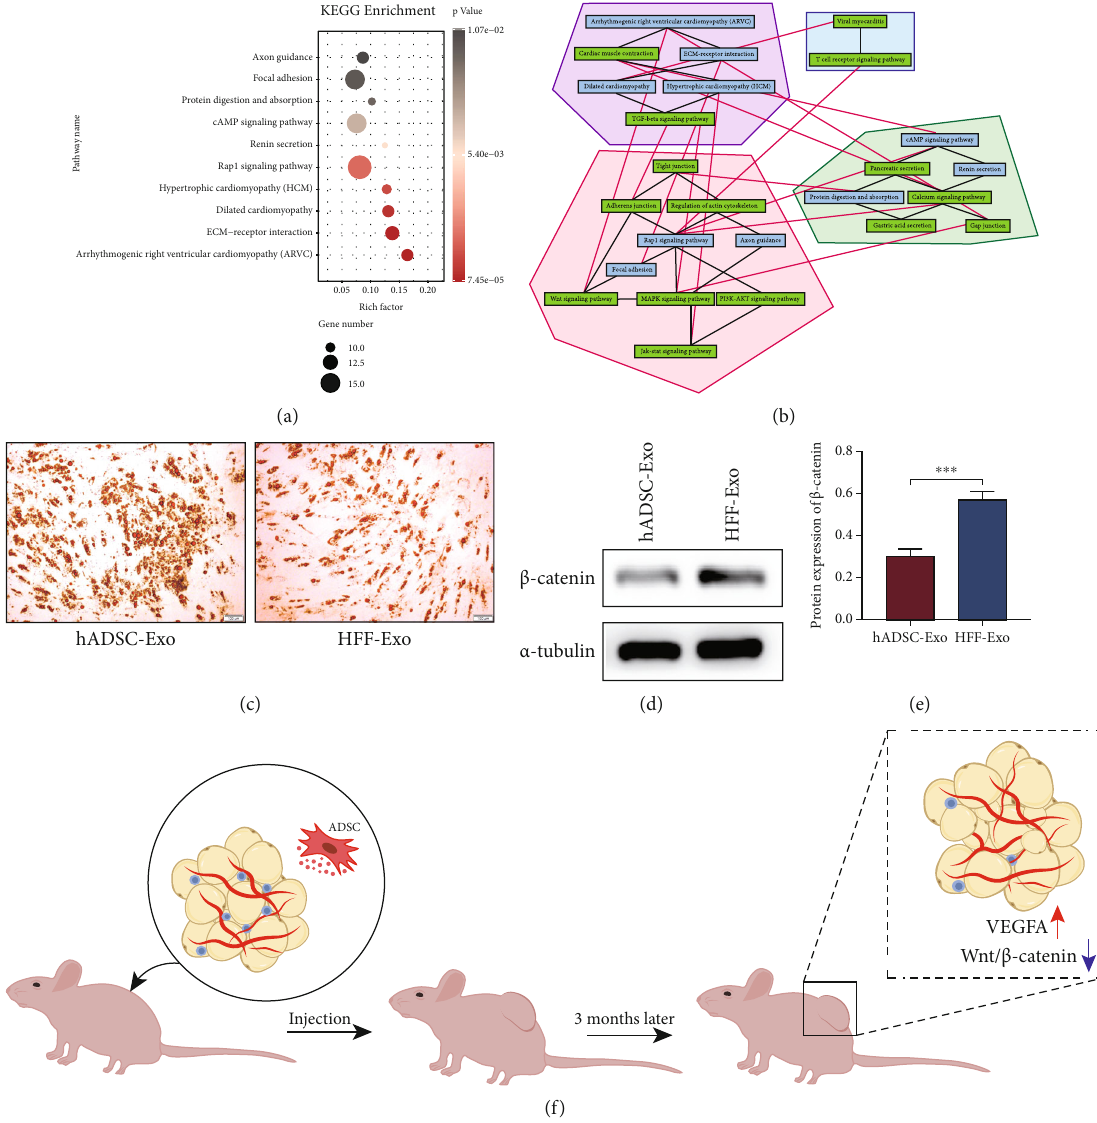
Figure 6: hADSC-Exo promoted adipogenic di ff erentiation of ADSC in adipose grafts. (a) The category of “ KEGG enrichment ” of the target DEGs. (B) Clusters of pathways each one presented by a di ff erent color. The black lines are the connections between nodes that form the identi fi ed lusters, while the red ones are those excluded by the algorithm. (c) Cell adipogenic di ff erentiation assays showed that hADSC- Exo signi fi cantly promote ADSC adipogenic di ff erentiation. (d, e) The expression levels of β -catenin in fat grafts cotransplanted with hADSC-Exo or HFF-Exo. (f) A schematic diagram shows how hADSC-Exo promotes the angiogenesis of fat grafts and maintains the adipogenic di ff erentiation ability of ADSC to promote the retention of fat